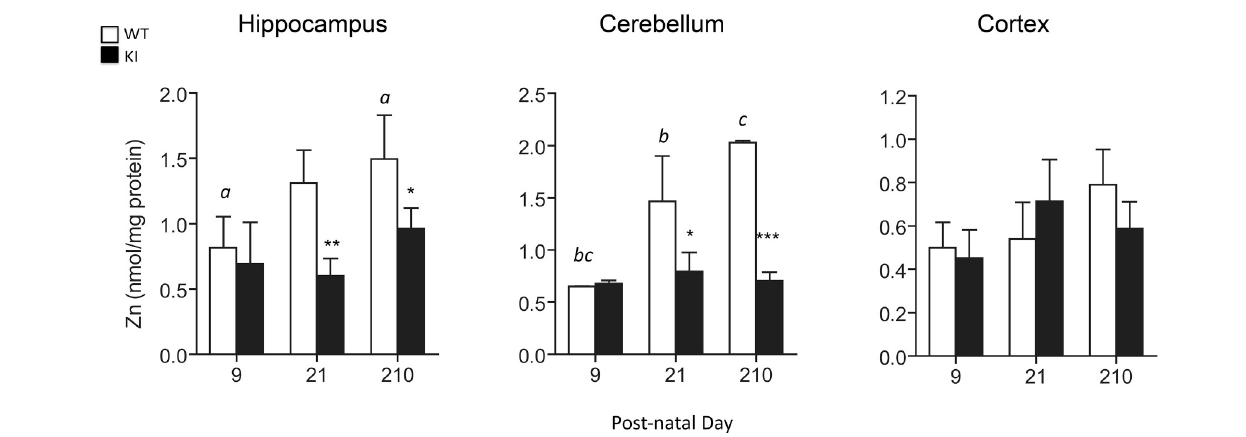
FIGURE 6 | Brain Zn concentrations in WT and KI mice. Total Zn levels were measured in whole hippocampus, cerebellum and cortex homogenates from WT and KI mice. Data are shown as mean ± SEM, n = 3–6 individuals per genotype, per time point, ran individually. Statistical analysis was performed by Two-way ANOVA, followed by Tukey’s HSD post-hoc test for multiple comparisons. Statistically significant differences between WT and KI at individual time-points are indicated by asterisks as follows: Hippocampus: * p = 0.0425; ** p = 0.0070; Cerebellum: * p = 0.0158; *** p = 0.0003. Statistically significant differences among time points are indicated by letters as follows: p = 0.0190 ( a ), p = 0.0144 ( b ), p = 0.0003 ( c ). Further statistical details on the genotype, age, and genotype × age effect can be found in Table 3